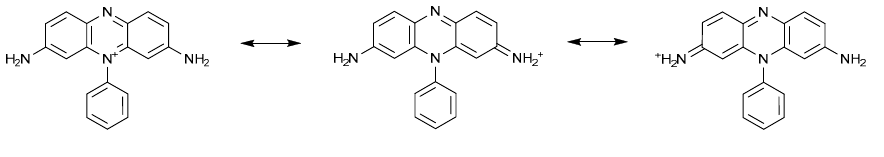
Scheme 15. Phenosafranine structure. Figure 8. Reactive Red 195 structure. Scheme 15. Phenosafranine structure. Scheme 15. Phenosafranine structure.